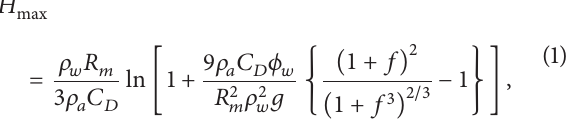
Figure 1: Images of small condensed micro water droplets (“sec- ondary droplet”) resting on (adhered) hydrophobic micro “parti- cles” forming a “particle-droplet pair” which is spatially confined (at the liquid-air interface) to a larger macro droplet (“host drop”). The process occurs spontaneously from condensation conditions occurring on the particle-seeded superhydrophobic surface. (a) Opticalimageshowingnumerousparticle-dropletpairswithdroplet sizes typically around 30 𝜇 m in diameter. (b) Higher resolution image of 3 secondary droplets residing on individual particles. (c) A single secondary droplet adhered to a particle (forming the particle- droplet pair) showing the droplet nucleation site at the top of the